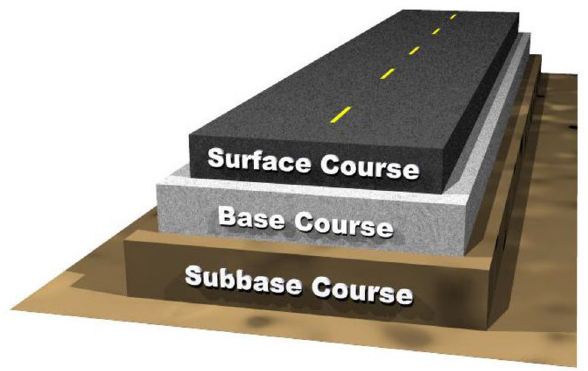
Fig. 2 The general relation between the water content and dry